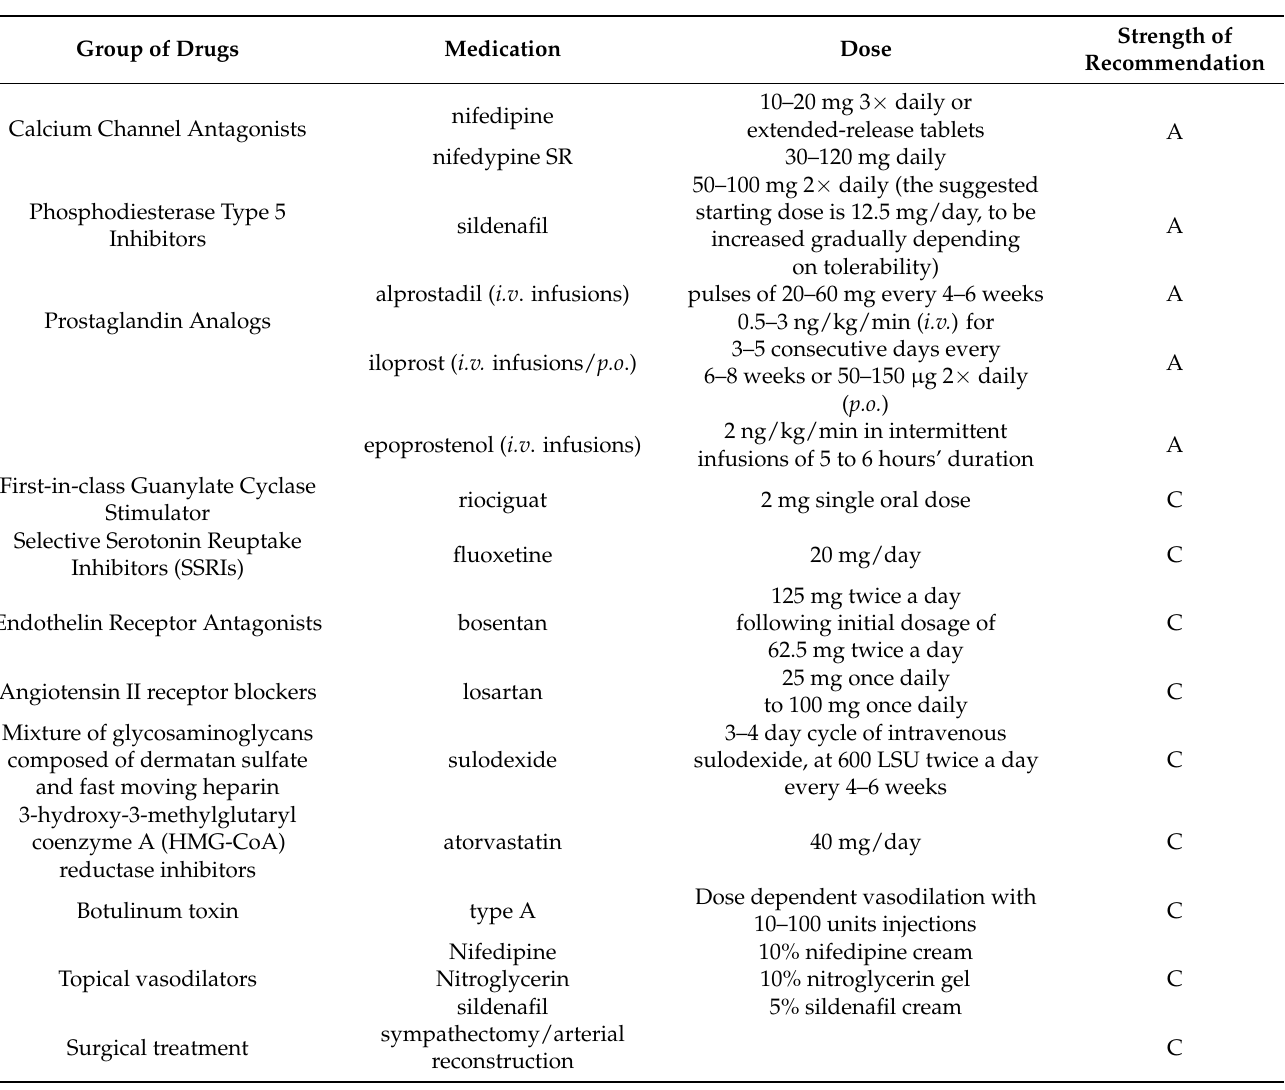
Table 3. Pharmacotherapy options in management of Raynaud’s phenomenon. A-level recommen- dation is based on consistent and good-quality patient-oriented evidence; B-level recommendation is based on inconsistent or limited-quality patient-oriented evidence; C-level recommendation is based on consensus, usual practice, opinion, disease-oriented evidence, or case series for studies of diagnosis, treatment, prevention, or